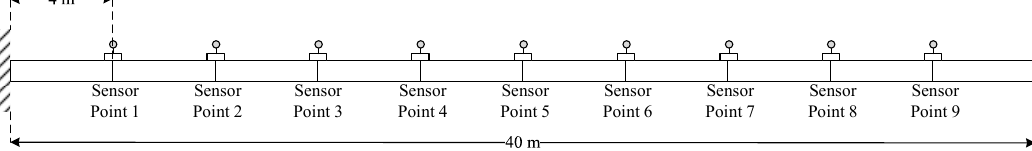
Figure 18. Configuration of numerical bridge model.